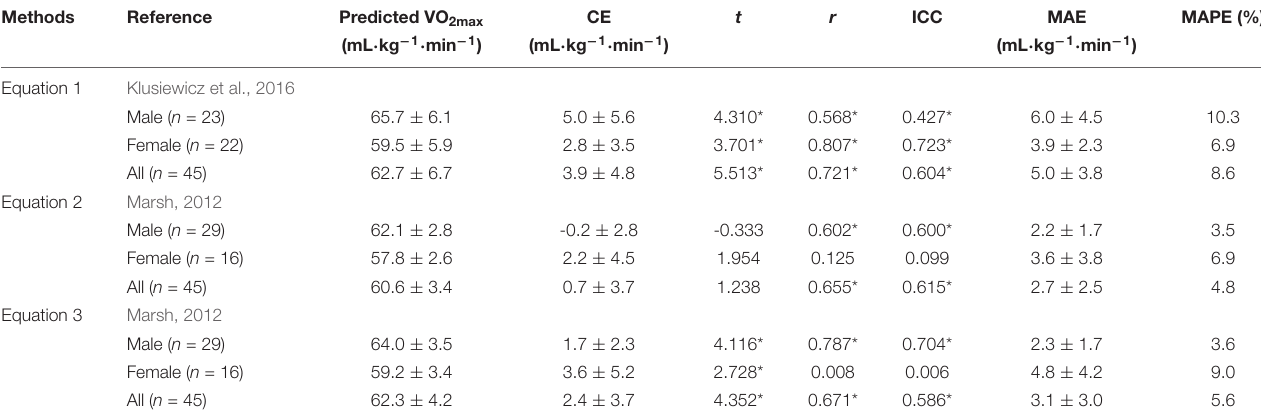
TABLE 4 | Descriptive examination of the correlations and differences between other indirect methods and the measured VO 2max .